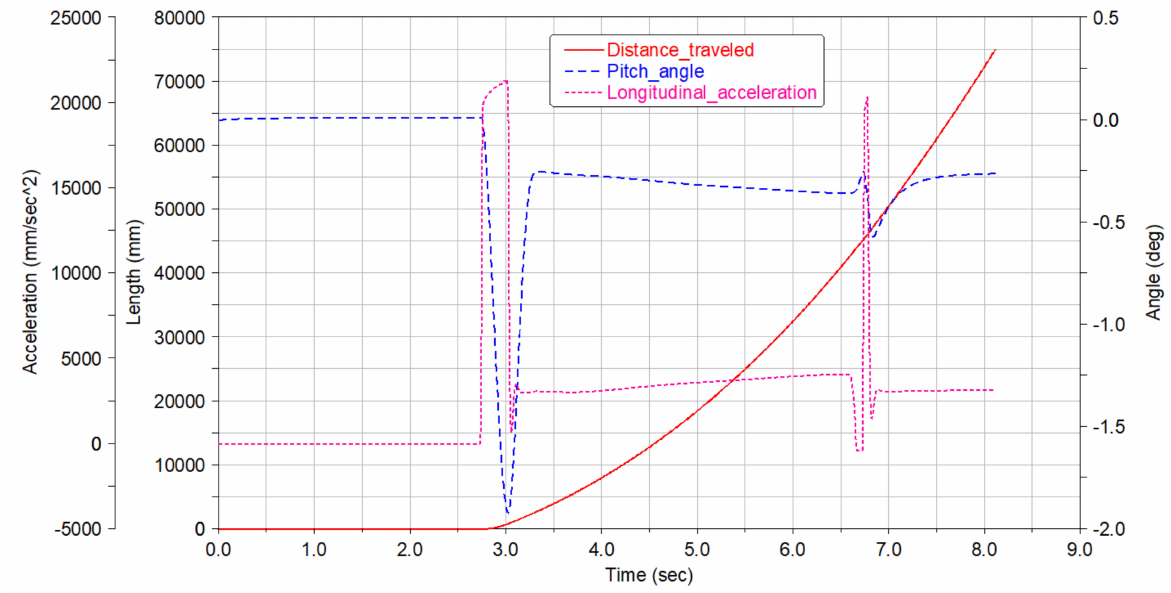
Figure 13. Acceleration Event—Baseline